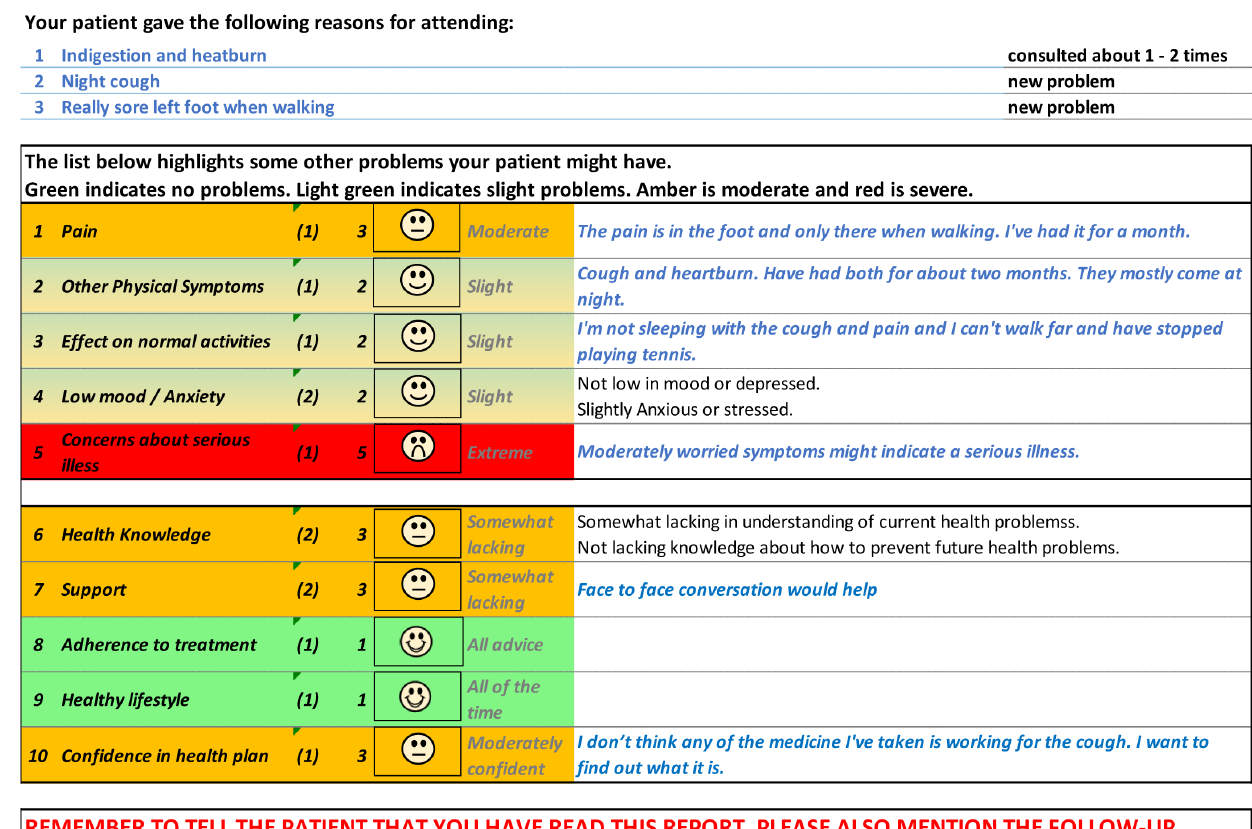
Figure 6. Pre-consultation report: Final version (end of intervention